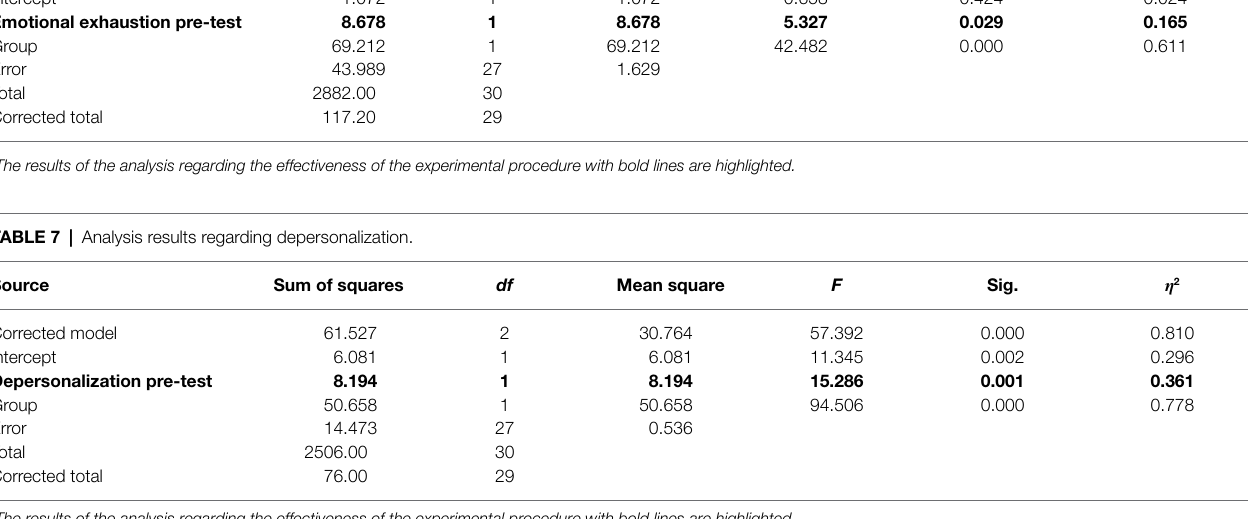
TABLE 6 | Analysis results regarding emotional exhaustion.